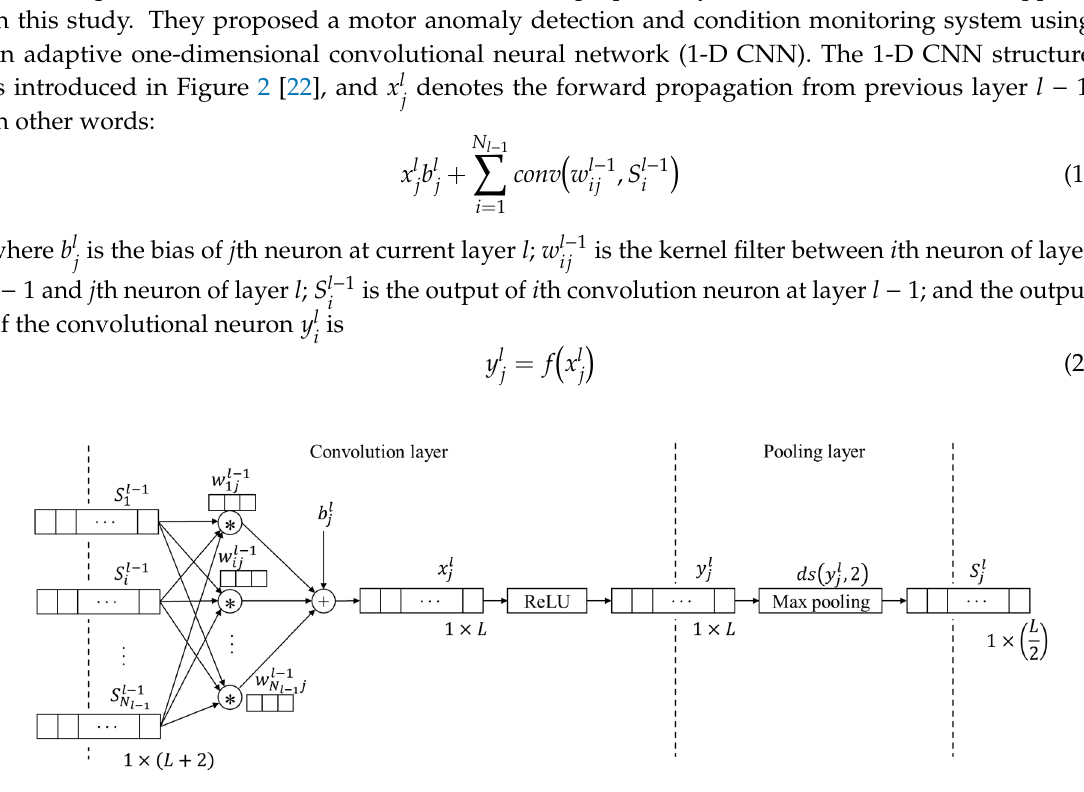
Figure 2. The one-dimensional convolutional neural network (1-D CNN) structure illustration: convolution and pooling operations [22].